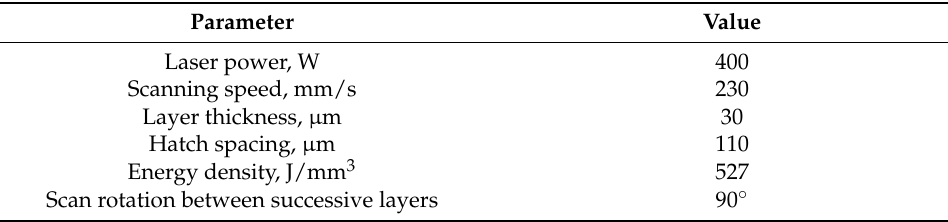
Table 2. SLM processing parameters are used to manufacture aluminum